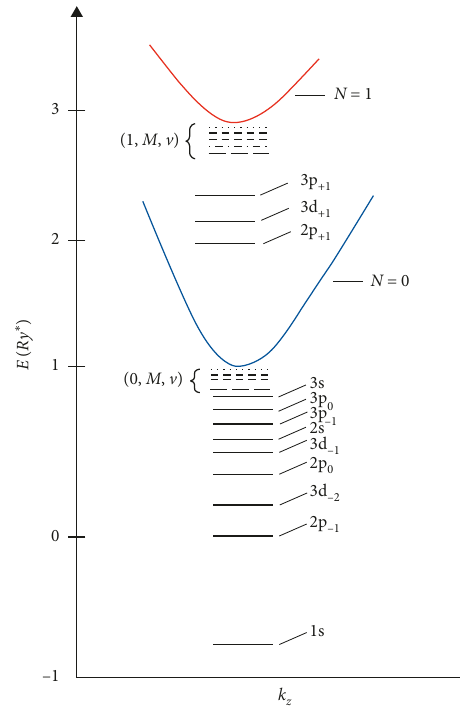
excited impurity 1